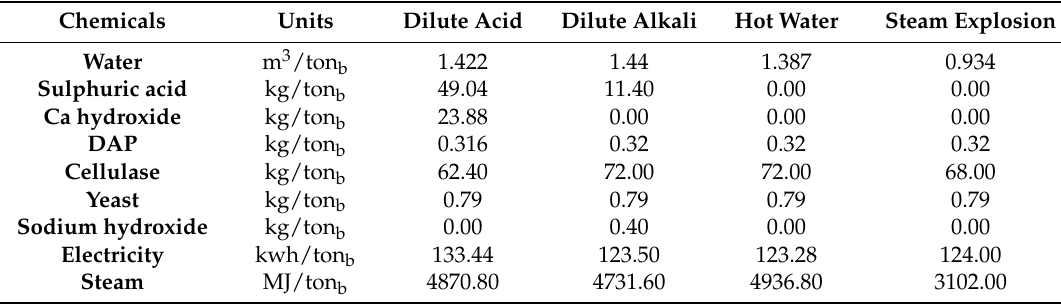
Table 2. Energy and chemicals consumption through the various bioethanol production